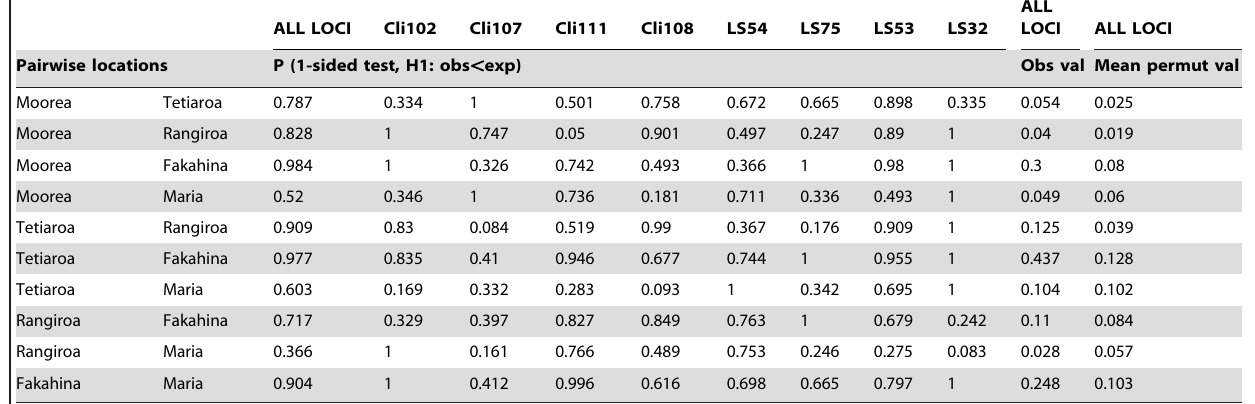
Table 3. R ST /p R ST results from